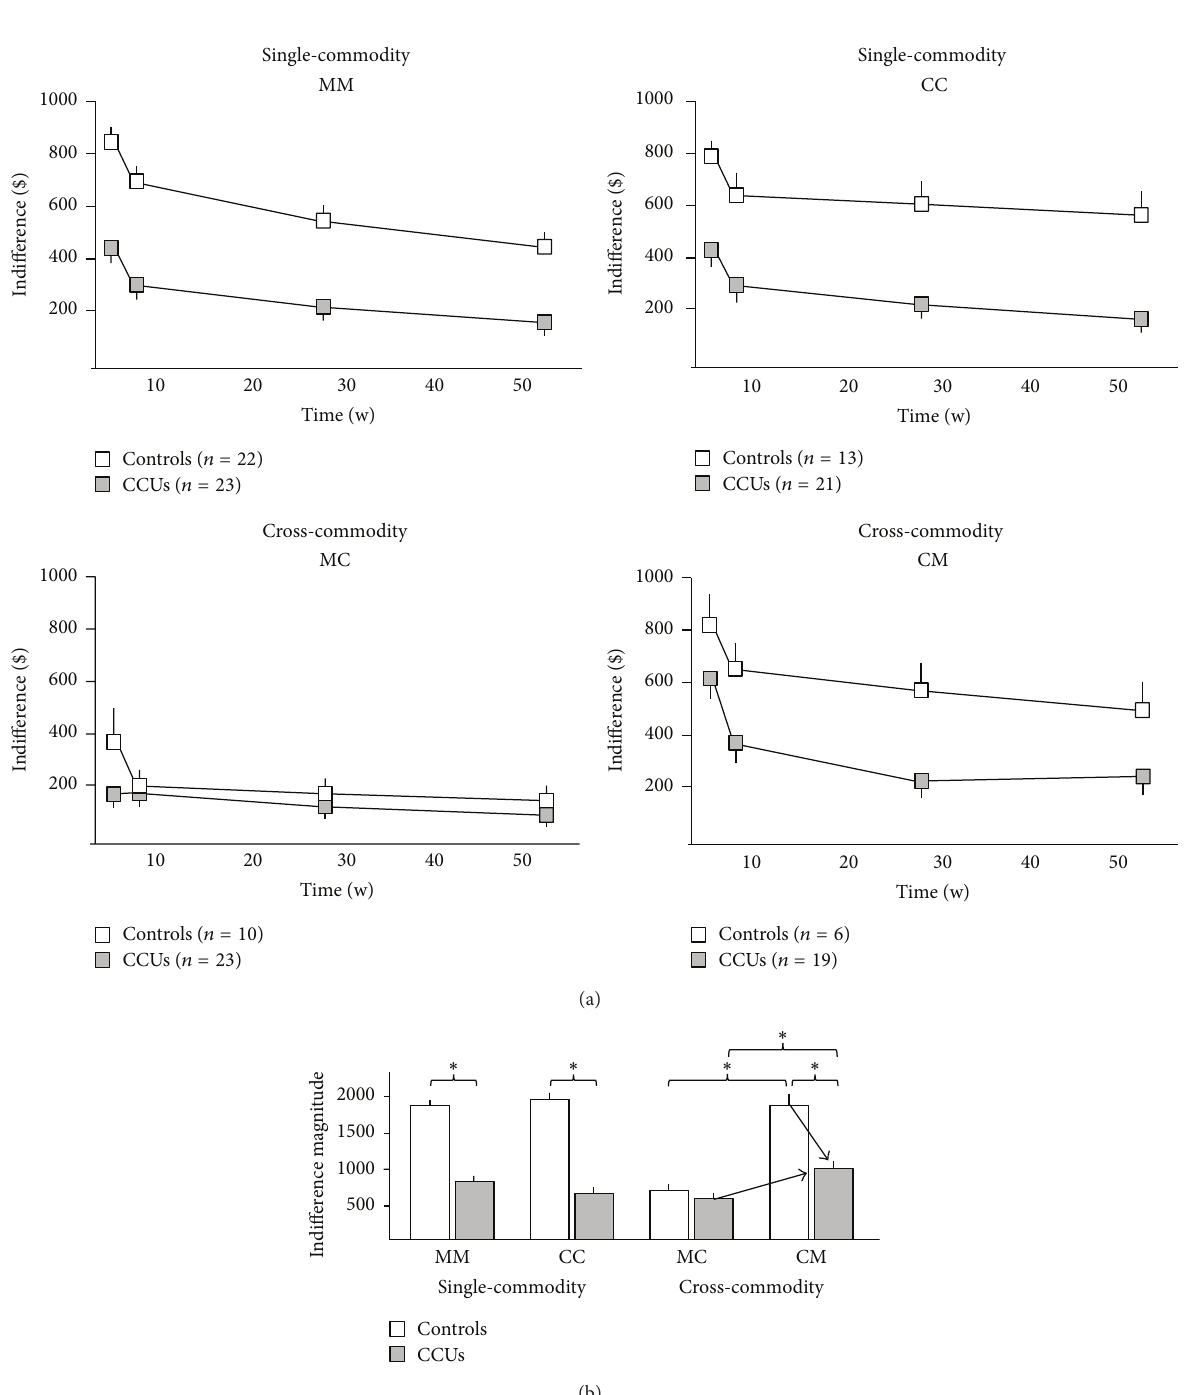
Figure 3: Temporal discounting behavior. (a) Indifference amounts (mean ± SEM) at each of four future time points (1, 4, 26, and 52 weeks) in nonexclusive responders in each group for single-commodity and cross-commodity tasks. In single-commodity tasks individuals chose between immediate or delayed money (MM) or cocaine (CC). In cross-commodity tasks individuals chose between immediate money or delayed cocaine (MC) or between immediate cocaine or delayed money (CM). (b) Comparison of indifference magnitudes, measured by area under the indifference curves in each task. Larger magnitudes reflect more value placed on the future. Conversely, smaller values reflect less value placed on the future. CCUs devalued future money and cocaine more than Controls during single-commodity tasks. During cross- commodity tasks, arrows point out that while CCUs devalue delayed money more than Controls, they valued delayed money significantly more than delayed cocaine. ∗ 𝑃 < 0.01